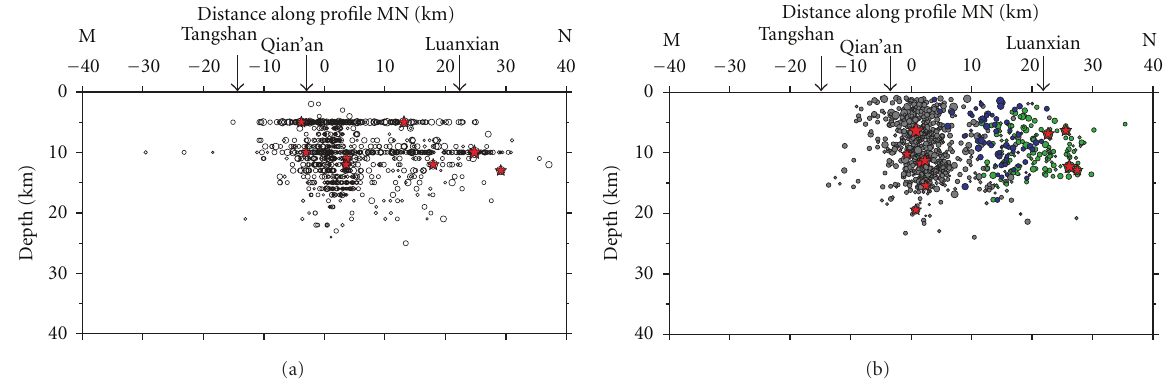
Figure 13: Cross-section along profile MN of focal depth before (a) and after (b) relocation using tomoDD in the Tangshan area. Origin of coordinates is set at the intersection point of MN and TT (cid:5) . Other symbols are the same as in Figure